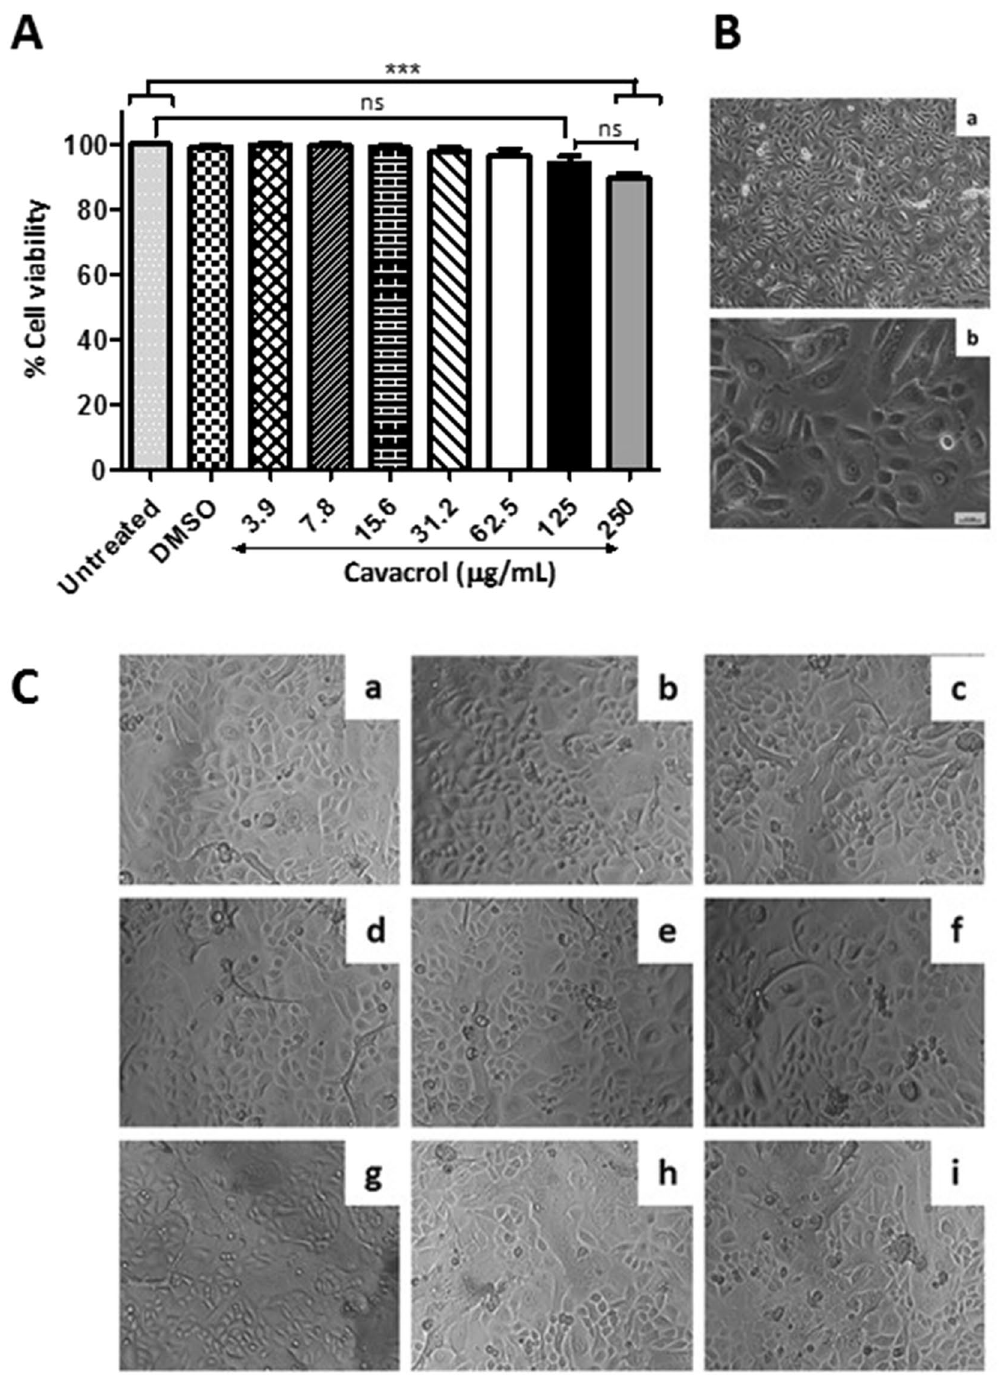
Figure 5. Carvacrol is not cytotoxic to the human tonsil epithelium cells. ( A ) Cell viability was measured using the MTS assay after treating human tonsil epithelium cells (TonEpiCs) with 15.6, 31.3, 62.5, 125, and 250 µg/mL carvacrol for 24 h. Absorbance was measured at 490 nm. Data are shown as mean ± SE from three independent experiments, each in triplicate. Differences among means were compared with untreated TonEpiCs (ANOVA, Tukey’s test). ( B ) Morphology of TonEpiCs grown in poly-l-Lysine coated flask with tonsil epithelial growth medium at 90% confluence was observed using a phase-contrast microscope. (a) Magnification, × 100; (b) Magnification, × 400. ( C ) TonEpiCs treated with different carvacrol were photographed using a phase-contrast microscope at × 100 magnification. Representative photographs captured at 24 h post-treatment in three independent experiments are shown. (a) untreated; (b) vehicle control (0.25% DMSO) and carvacrol treatments of (c) 3.9 µg/mL, (d) 7.8 µg/mL, (e) 15.6 µg/mL, (f) 31.3 µg/mL, (g) 62.5 µg/mL, (h) 125 µg/mL, and (i) 250 µg/